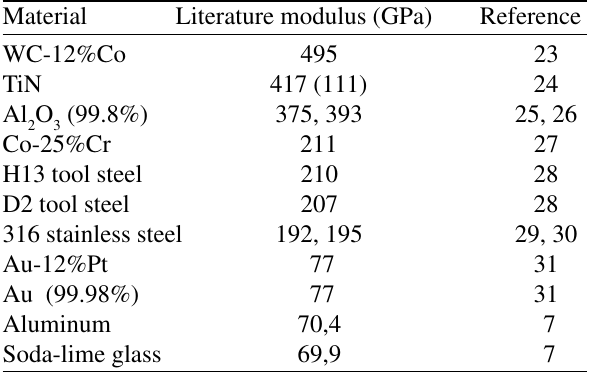
Table 2. Elastic moduli reported in literature for the used materials.